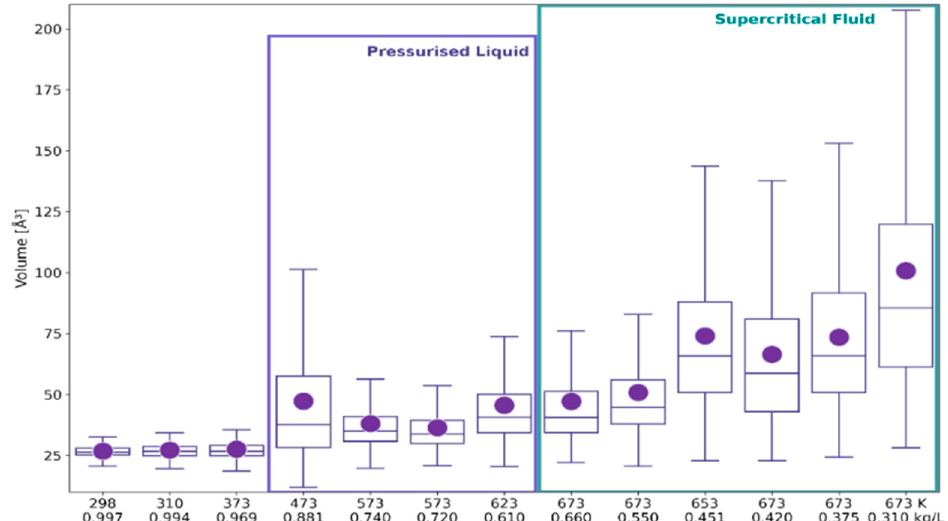
Figure A1. Box-and-whiskers plots displaying median, 1st and 3rd quartiles, minimum (bottom whisker), maximum (upper whisker), and means (points) of statistical distributions of VP-volume obtained for the thermodynamic states defined by temperature and density, as in Table 1.